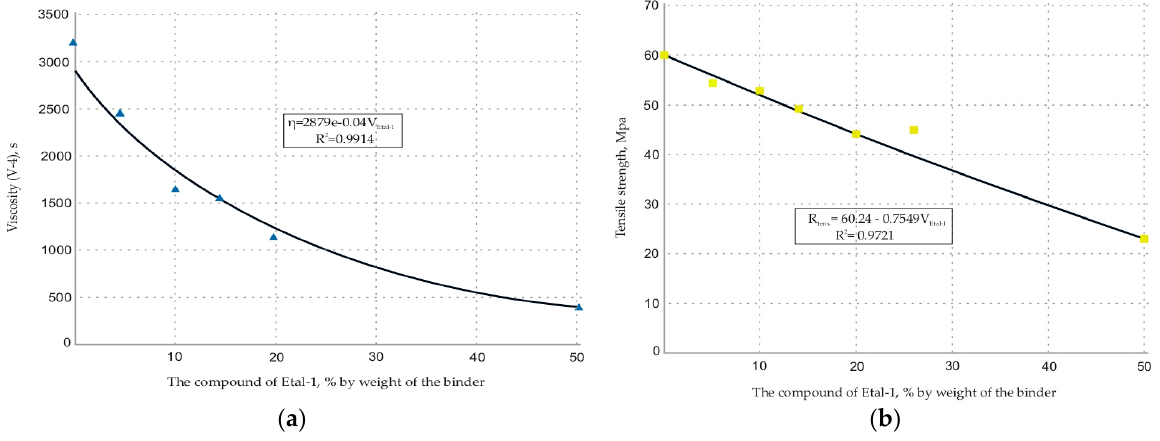
Figure 1. Change in viscosity ( a ) of epoxy binders and tensile strength ( b ) of polymers based on them depending on the content of Etal-1. Table 3. Evaluation of the effectiveness of modifying the epoxy resin ED-20 with an aliphatic diluents of the brand Etal-1.